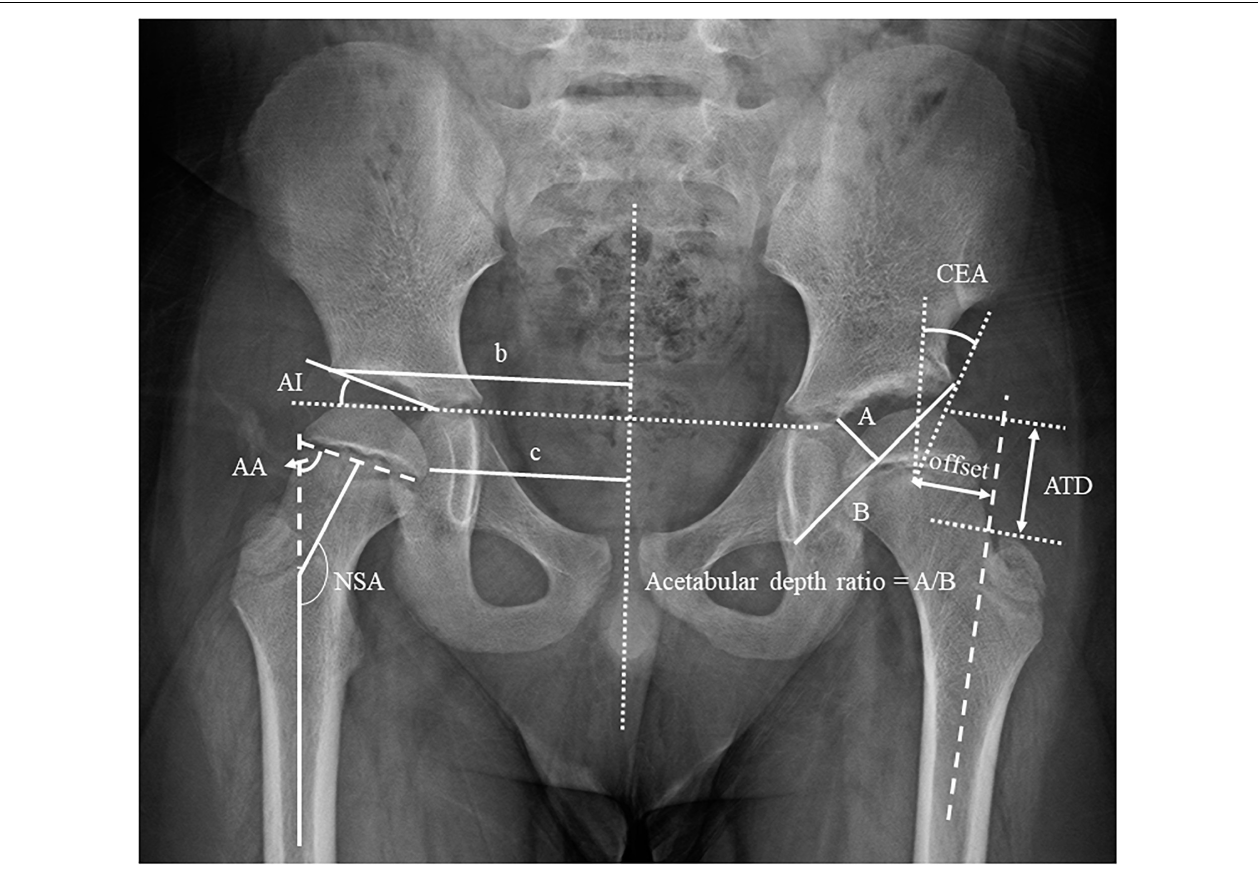
FIGURE 1 | Definitions of the radiographical measurements of the morphology of the hip. NSA, neck-shaft angle; AI, acetabular index; CEA, center-edge angle; A/B, acetabular depth ratio; ATD, articulotrochanteric distance; c/b ratio; AA, Alsberg angle.